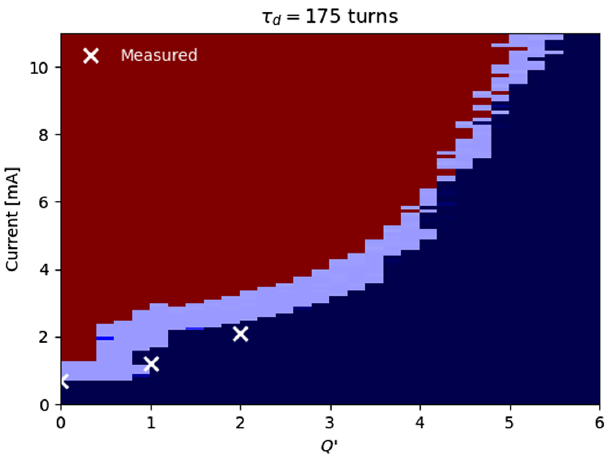
FIG. 14. Instability threshold in the presence of a vertical transverse feedback as a function of chromaticity. The white crosses are measurements of horizontal instabilities and the shaded regions show the simulated area of stability (dark blue) or instability (red, light